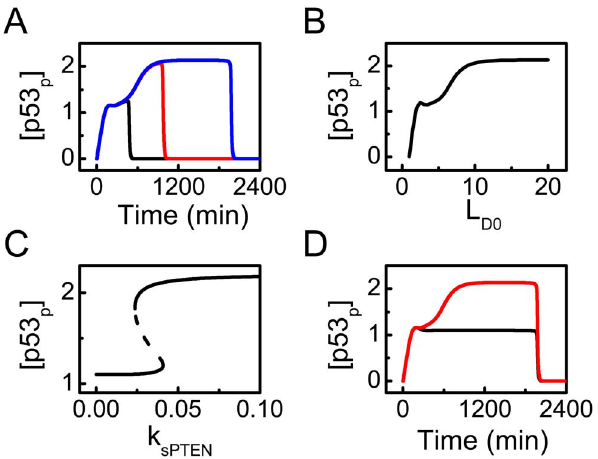
Figure 5. Regulation of cell cycle progression and apoptosis by p21. (A) Time courses of [p21 tot ] (black), [Rb p ] (red), and [E2F1] (blue) at L D0 ~ 5 . (B) Time courses of [p21 tot ] (black), [E2F1] (green), [Apaf-1] (red), and [Casp9] (blue) at L D0 ~ 20 . (C) Bifurcation diagram of [E2F1] vs. the p53-inducible production rate of p21, k sp21 . (D) Time courses of [p21 tot ] (black), [E2F1] (blue), [CytoC] (red), and [Casp9] (green) with k sp21 ~ 0 : 8 and L D0 ~ 20